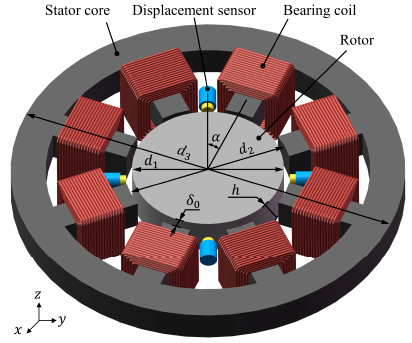
Figure 1. Topology of the slice rotor supported by one active magnetic bearing unit. 𝑥/𝑦 , radial di- rection; 𝑧 , axial direction. Table 1. The parameters of the AMB system.